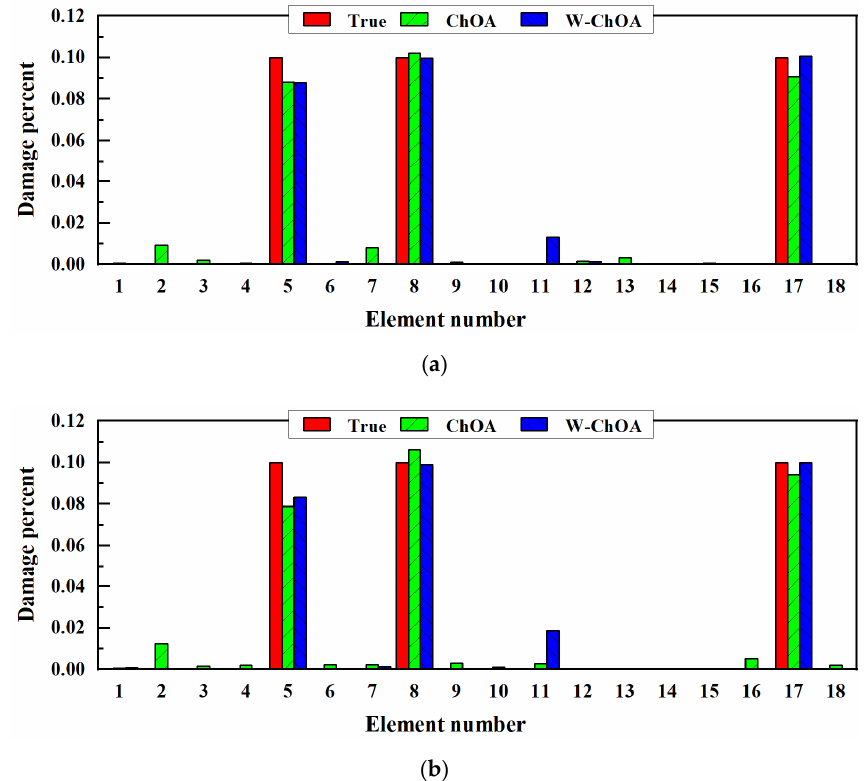
Figure 7. Triple damages detection results of two-story rigid frame by two chimp-based optimization algorithms. ( a ) 5% noise level. ( b ) 10% noise